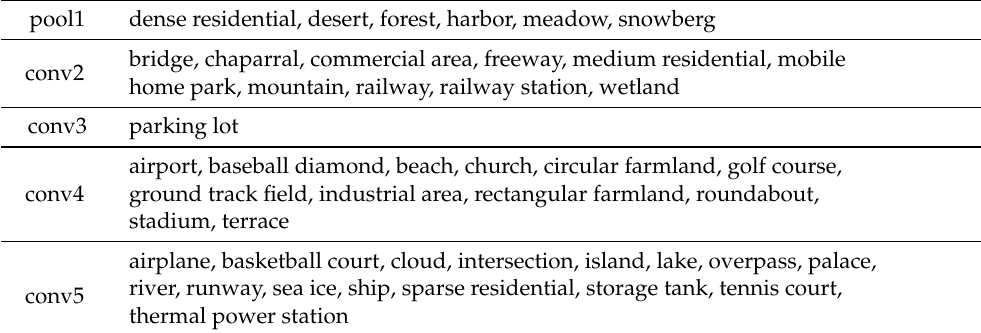
Table 5. The optimal explanation layer from AlexNet for each class of NWPU-RESIS45 dataset. pool1